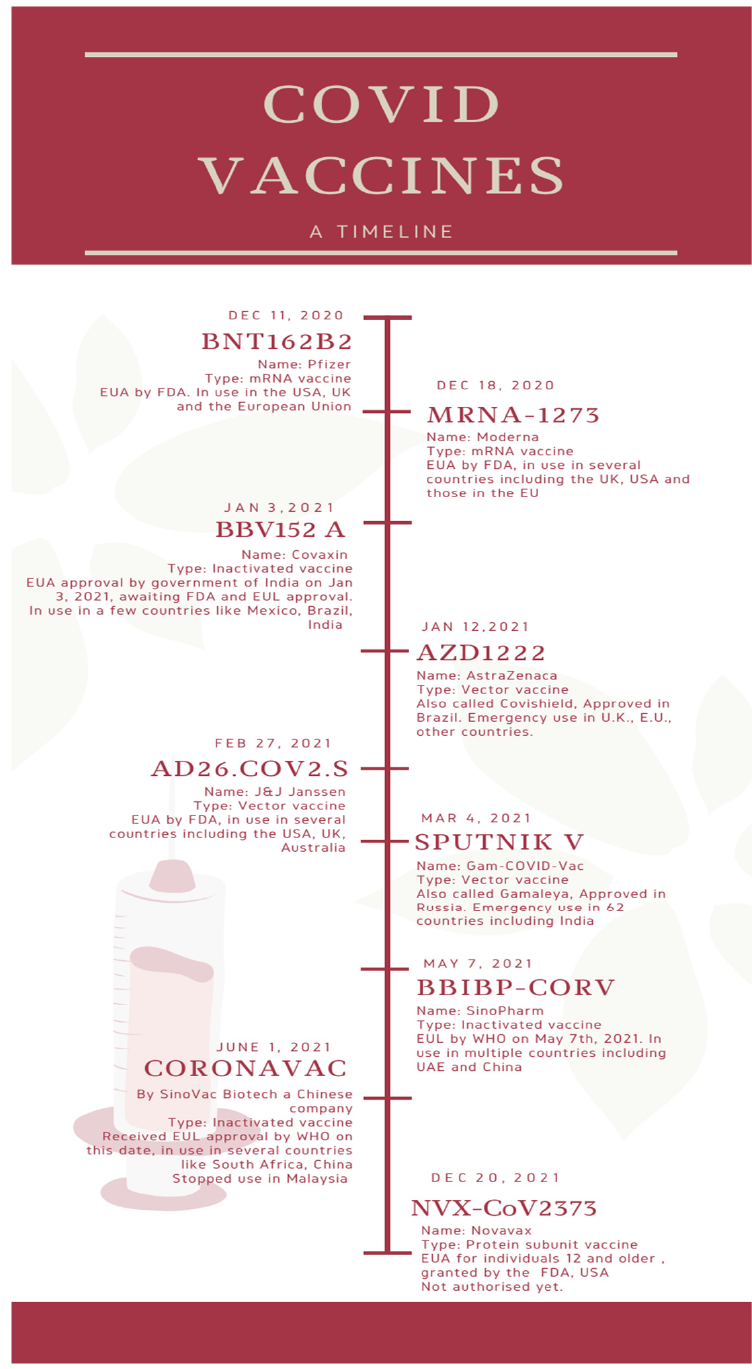
Figure 1. A timeline of the major COVID vaccines [25].